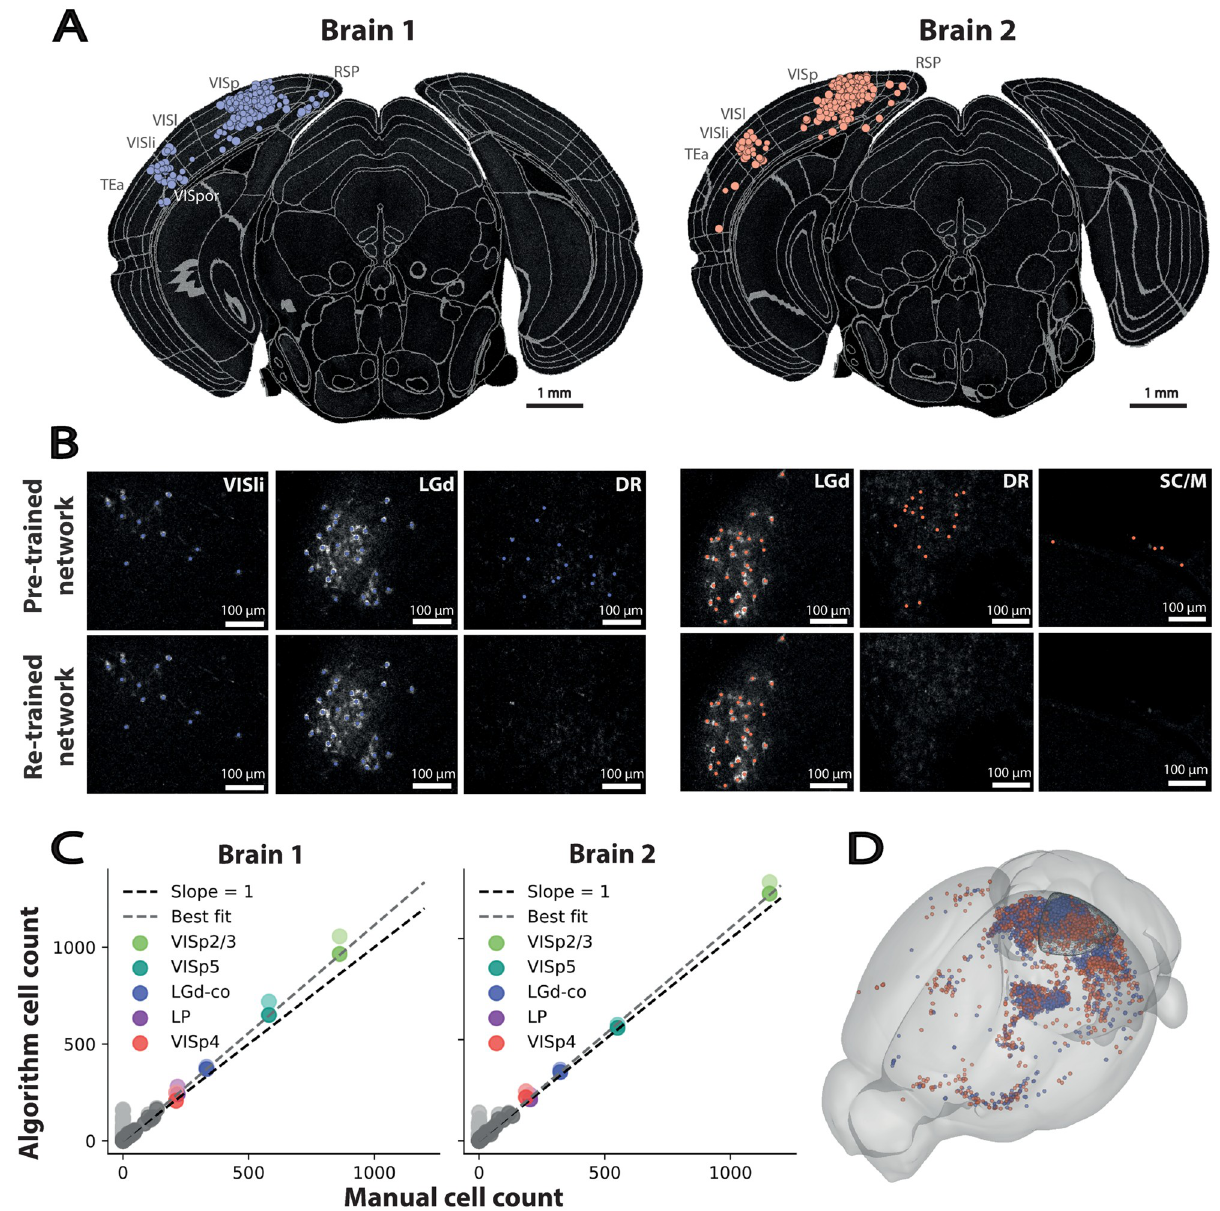
Fig 4. Application of the algorithm to unseen data. Presynaptic neurons labelled by rabies viral injection into layer 2/3 primary visual cortex in Penk-Cre mice. A: Detected cells overlaid on raw data along with the brain region segmentation for Brain 1 (blue) and 2 (orange). The size of the coloured disk represents the proximity of the cell centroid to the image plane displayed. Brain regions with detected cells shown: RSP—Retrosplenial area, VISp—Primary visual area, VISl—lateral visual area, VISli—Laterointermediate area, TEa—Temporal association areas. B: Comparison of cell detection before and after re-training the pre-trained network in different regions of the image. Cells with different morphologies are correctly detected in both dense and sparse regions, and artefacts are rejected. VISli—Laterointermediate area, LGd—Dorsal part of the lateral geniculate complex, DR— Dorsal nucleus raphe, SC/M—Superior colliculus & meninges. C: Comparison of cell counts per ARA brain region between the algorithm and the mean of the two expert counts. Lighter points represent results before re-training and darker points after re-training. Best fit shown after re-training. Five regions with the highest number of detected cells coloured, VISp2/3—Primary visual area, layer 2/3, VISp5—Primary visual area, layer 5, LGd-co— Dorsal part of the lateral geniculate complex, core, LP—Lateral posterior nucleus of the thalamus, VISp4—Primary visual area, layer 4. D: Visualisation of detected cells from both brains warped to the ARA coordinate space in 3D, along with the rabies virus injection site target (primary visual cortex, wireframe).